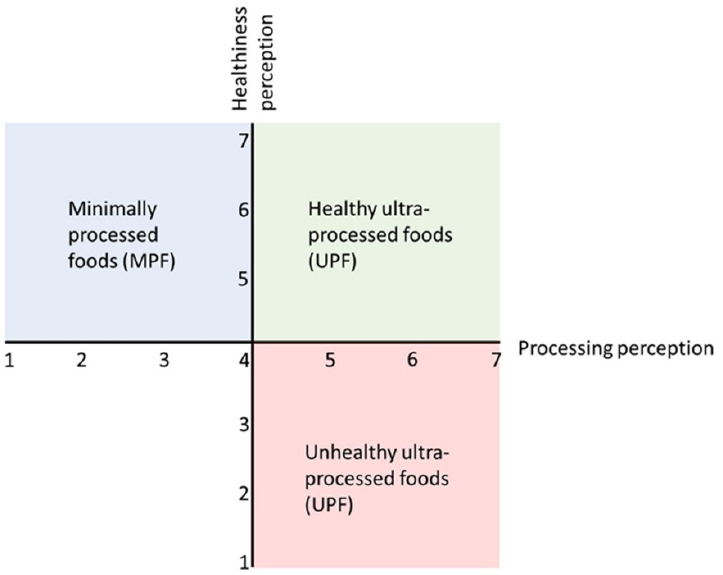
Figure 1. Expected distribution of food products based on the degree of healthiness and pro- cessing.